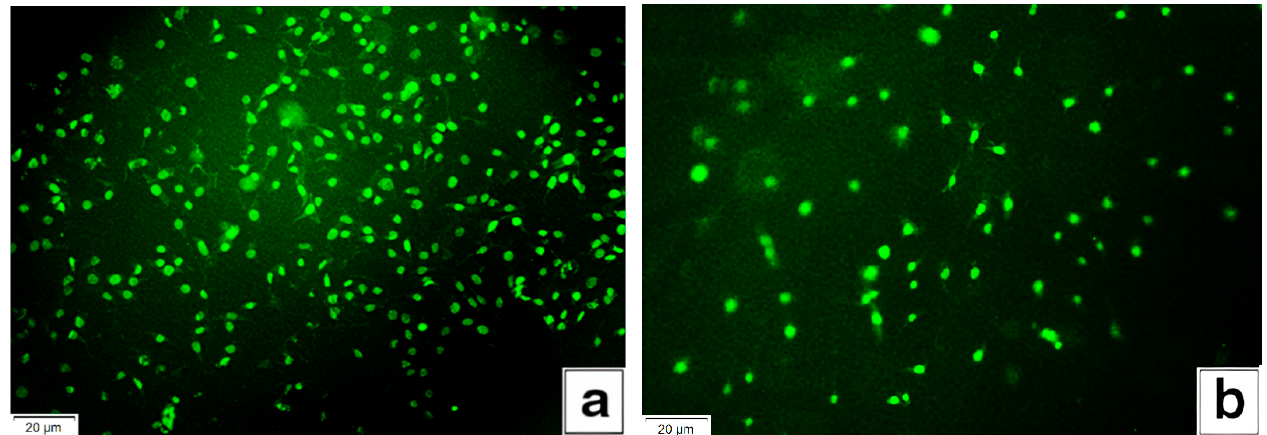
Figure 6. Micrographs of films, 24 h after colonization with fibroblasts. ( a ) A film based on a mixed composition of the composition “50% chitosan + 50%PLA”; ( b ) a film based on pure chitosan.